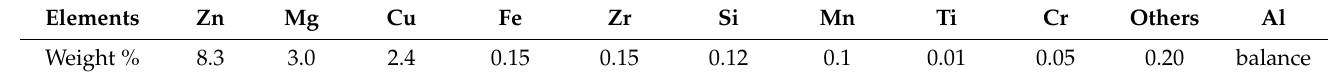
Table 1. Chemical composition of